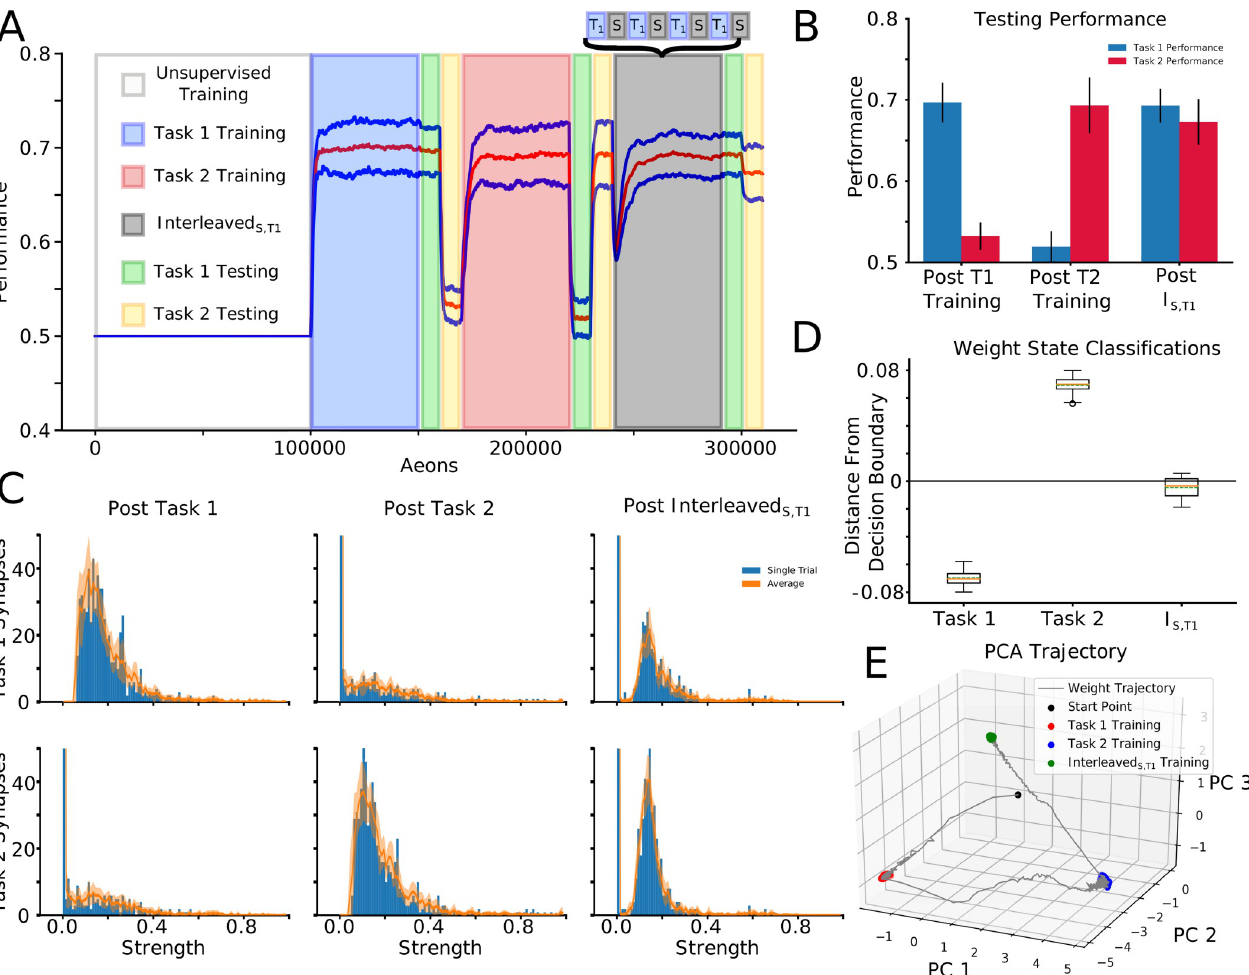
Fig 4. Interleaving periods of new task training with sleep allows integrating synaptic information relevant to new task while preserving old task information. (A) Mean performance (red line) and standard deviation (blue lines) over time: unsupervised training(white), Task 1 training (blue), Task 1/2 testing (green/yellow), Task 2 training (red), Task 1/2 testing (green/yellow), Interleaved S,T1 training (grey), Task 1/2 testing (green/yellow). Note that performance for Task 2 remains high at the end despite no Task 2 training during Interleaved S,T1 . (B) Mean and standard deviation of performance during testing on Task 1 (blue) and Task 2 (red). (C) Distributions of task-relevant synaptic weights (blue bars–single trial, orange line / shaded region–mean / std across 10 trails). The distributional structure of Task 1-relevant synapses following Task 1 training (top-left) is destroyed following Task 2 training (top- middle), but partially recovered following Interleaved S,T1 training (top-right). Similarly, the distributional structure of Task 2-relevant synapses following Task 2 training (bottom-middle), which was not present following Task 1 training (bottom-left), was partially preserved following Interleaved S,T1 training (bottom- right). (D) Box plots with mean (dashed green line) and median (dashed orange line) of the distance to the decision boundary found by an SVM trained to classify Task 1 and Task 2 synaptic weight matrices for Task 1, Task 2, and Interleaved S,T1 training across trials. Task 1 and Task 2 synaptic weight matrices had mean classification values of -0.069 and 0.069 respectively, while that of Interleaved S,T1 training was -0.0047. (E) Trajectory of H to O layer synaptic weights through PC space. Synaptic weights which evolved during Interleaved S,T1 training (green dots) clustered in a location of PC space intermediary between the clusters of synaptic weights which evolved during training on Task 1 (red dots) and Task 2 (blue